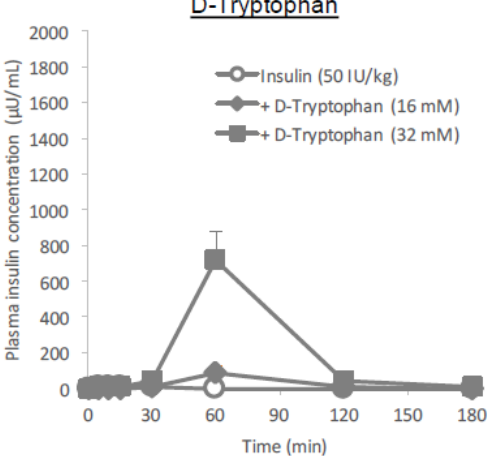
Figure 10. Time profiles of plasma insulin concentration after in situ administration of insulin (50 IU/kg) with or without D -tryptophan (16 or 32 mM) into rat ileal loop. Each data point represents the mean ± SEM of N =